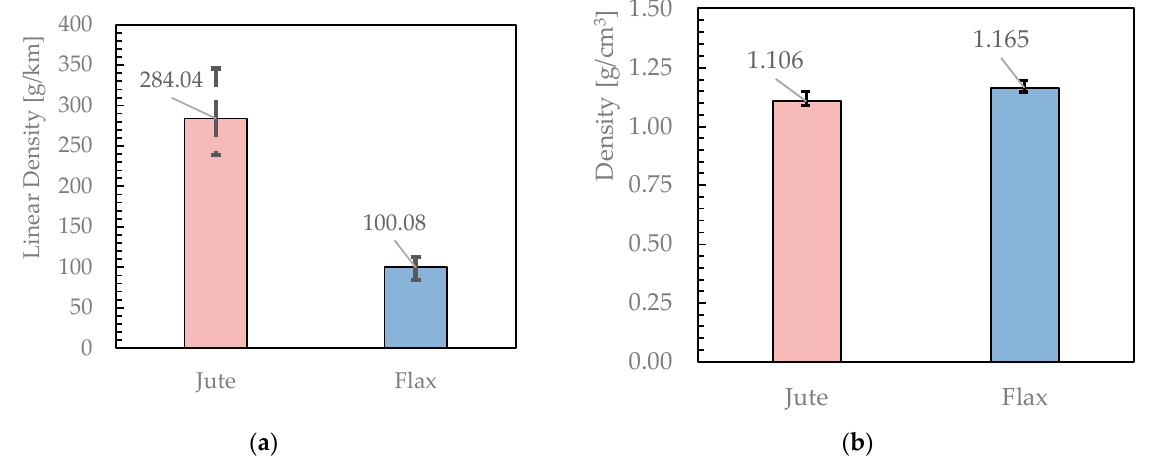
Figure 5. Linear density ( a ) and Density ( b ) of jute and flax yarns.